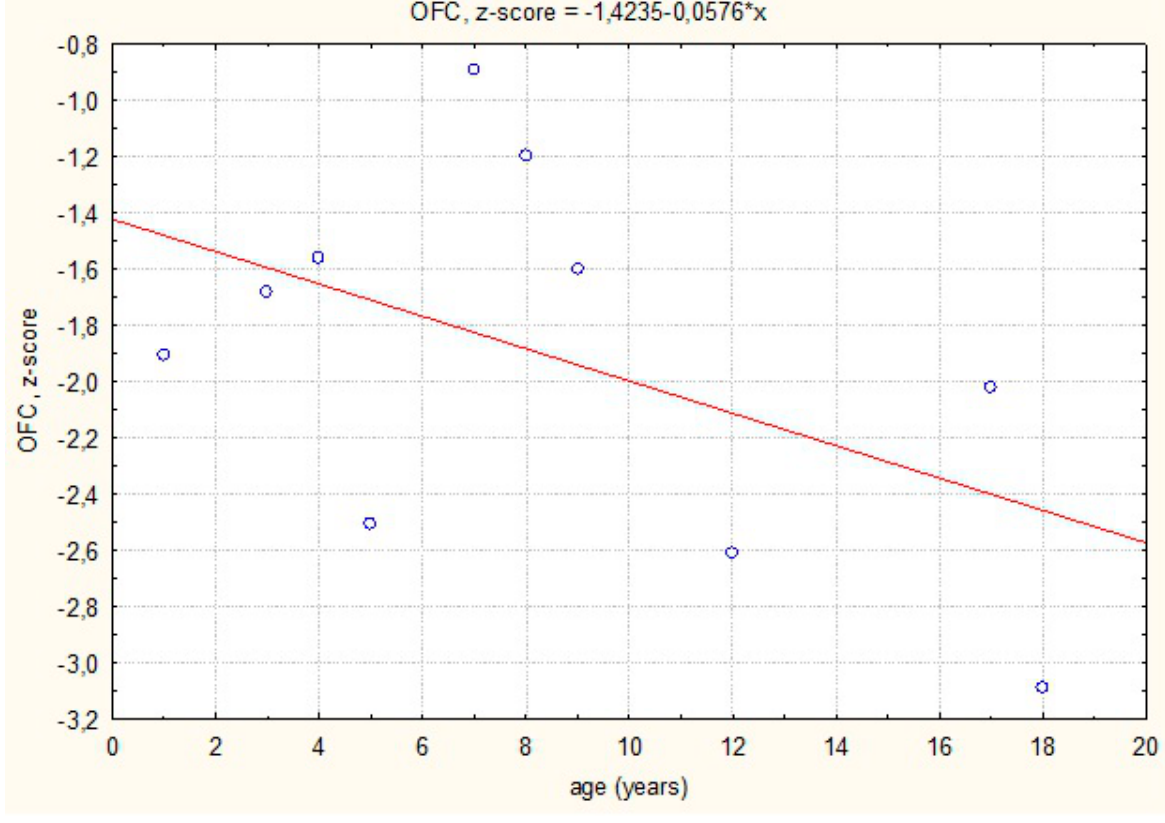
Figure 5. The straight-line regression of standardized head circumference against the adopted reference system.